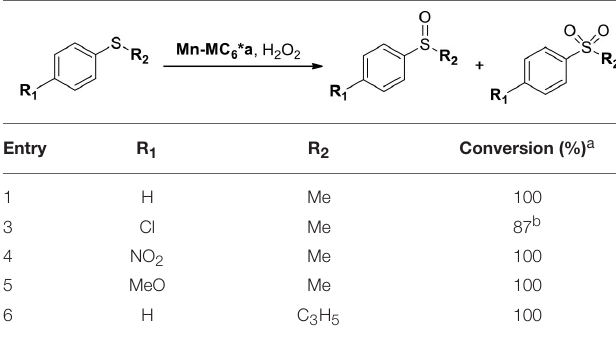
TABLE 4 | Mn-MC6 * a-catalyzed oxidation of thioethers.